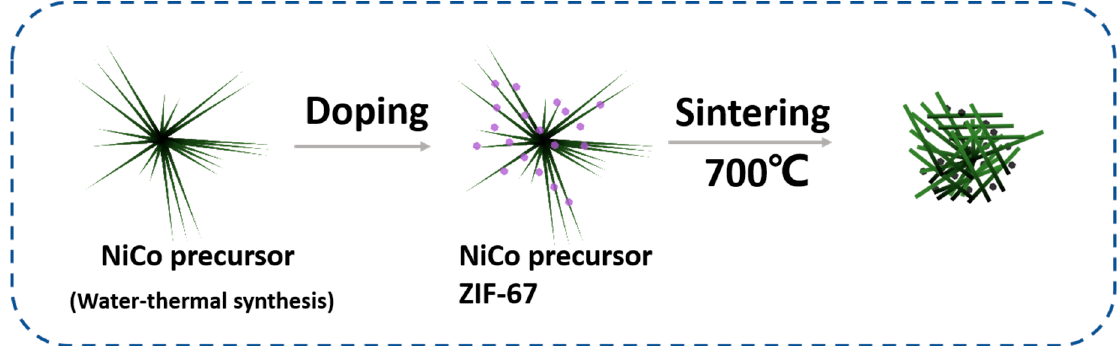
Figure 1. Schematic description for synthesizing Co 3 O 4 /NiCo 2 O 4 with high-temperature calcination of the ZIF-67/Ni-Co composite.